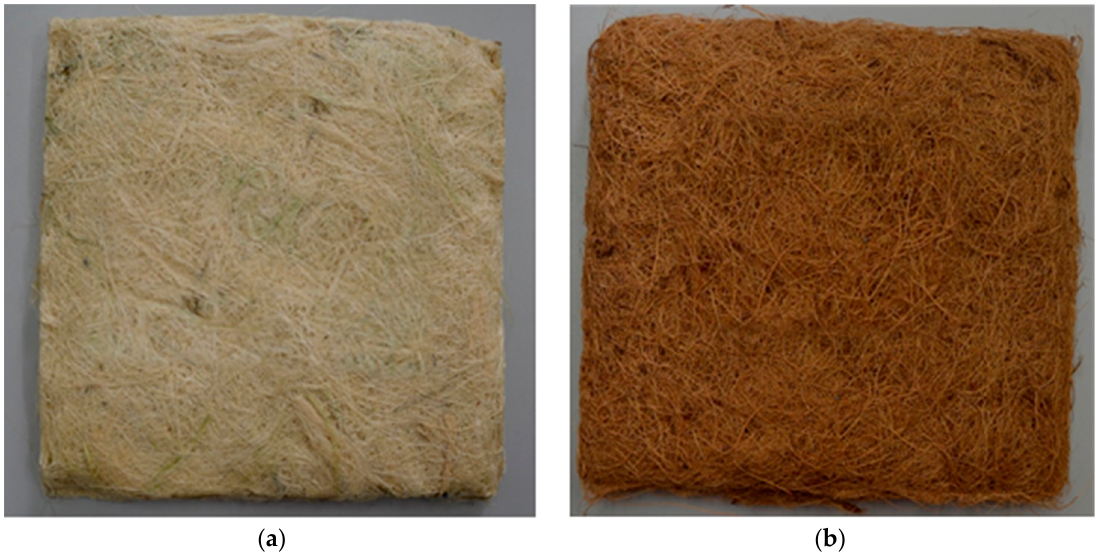
Figure 6. ( a ) Fique and ( b ) Coir panels developed by a chemical bonding method.